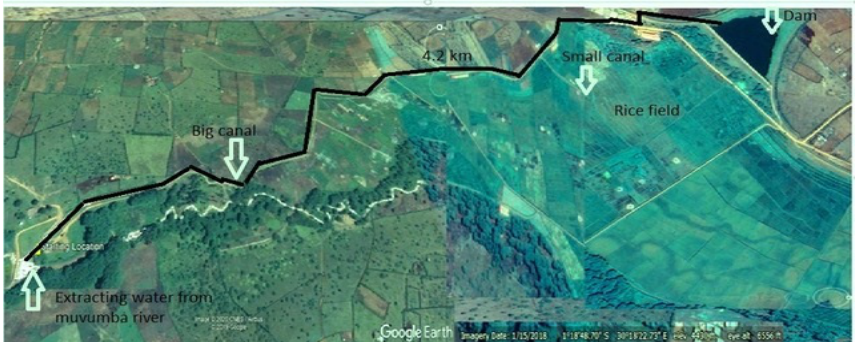
Figure 1. Rice fields and irrigation canals at Muvumba Valley Rice Plantation in Nyagatare,